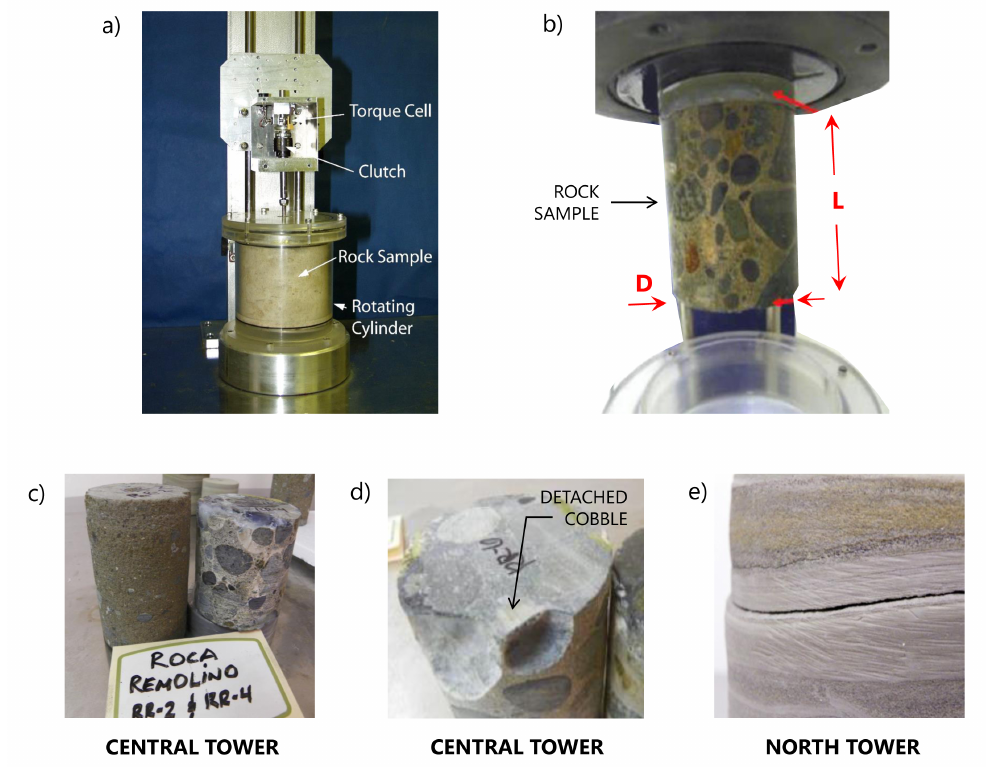
Figure 4. ( a ) A front view of RETA apparatus [38]. ( b ) A view of some of the samples and the involved dimensions. Taps at both extremes were also indicated (arrows in red). ( c , d ) Some samples of Remolinos rock after an erosion test. ( e ) A view of a sample from NT after an erosion test (figures extracted from